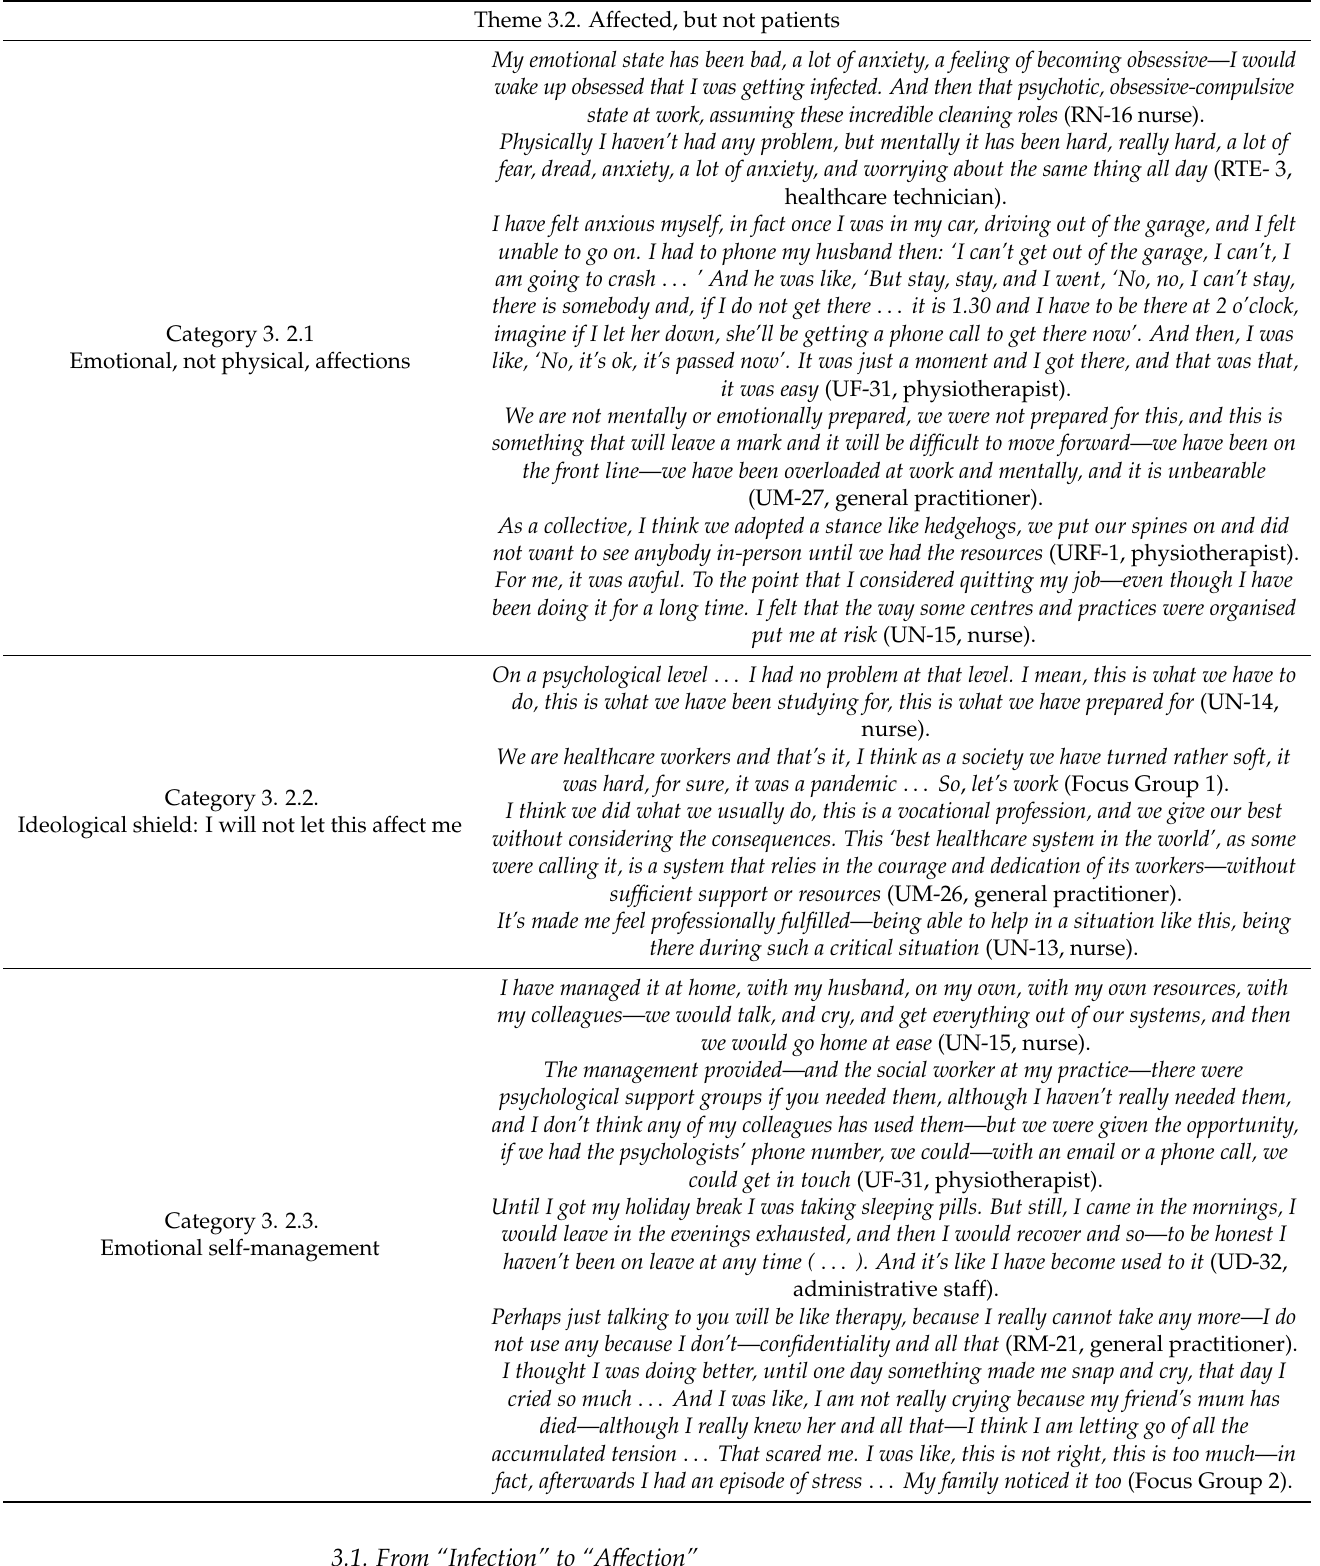
Table 3. Cont. Theme 3.2. Affected, but not